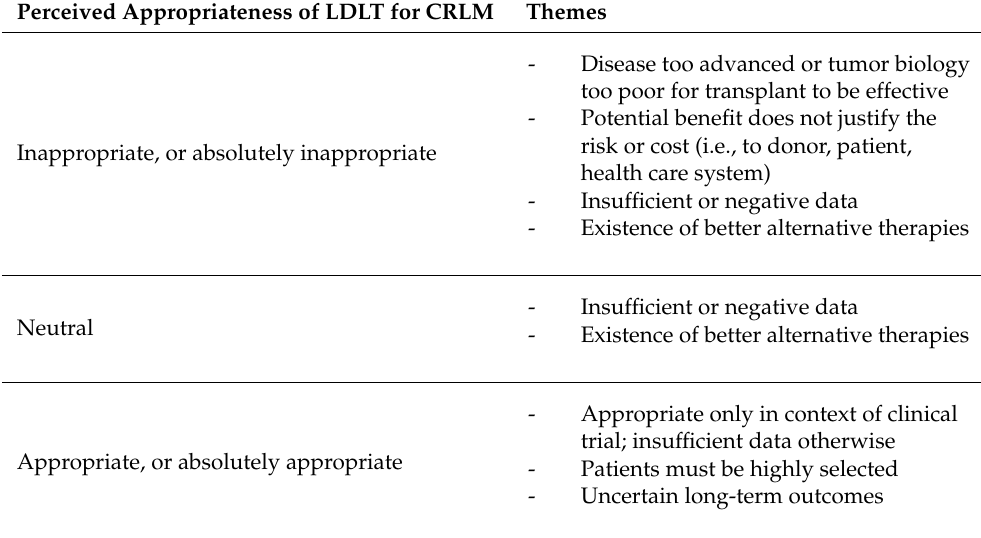
Table 4. Themes extracted from opinions related to perceived appropriateness of LDLT for CRLM. Perceived Appropriateness of LDLT for CRLM